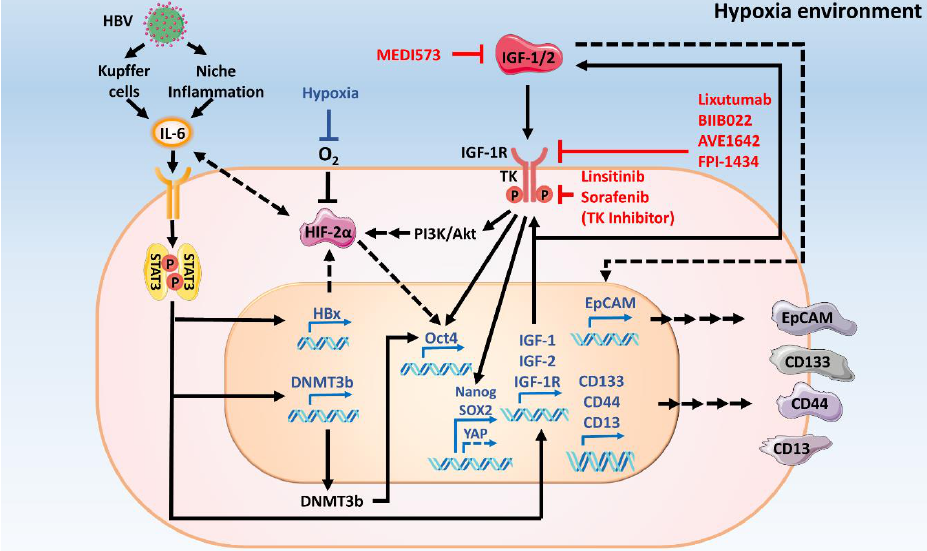
Figure 2. IGF/IGF-1R signaling induces cancer-related stemness in HCC. The formation of a hypoxic environment or the HBx protein can trigger and form a loop of IGF/IGF-1R signaling activation during HCC progression, leading to the activation of cancer stemness-related transcription factors and specific niches. Stimulation of these transcriptional pathways, such as Oct4, Nanog, and SOX2, and interactions in the niches increase cancer stemness and lead to the upregulation of stemness-associated cell surface markers, including EpCAM, CD133, CD44, and CD13. IGF-1, IGF-2, and IGF-1R targeting drugs and tyrosine kinase inhibitor (TKI) inhibit IGF/IGF-1R signaling, and thus discontinue the loop.